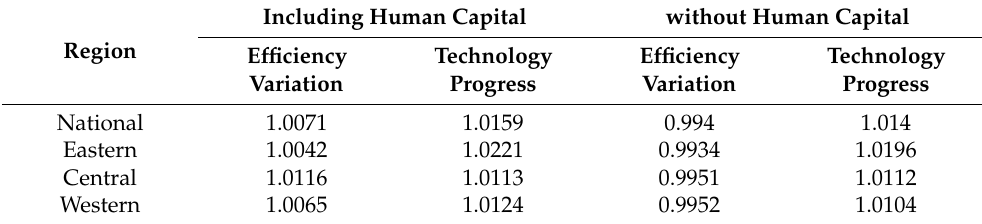
Table 6. Decomposition of regional GTFP.